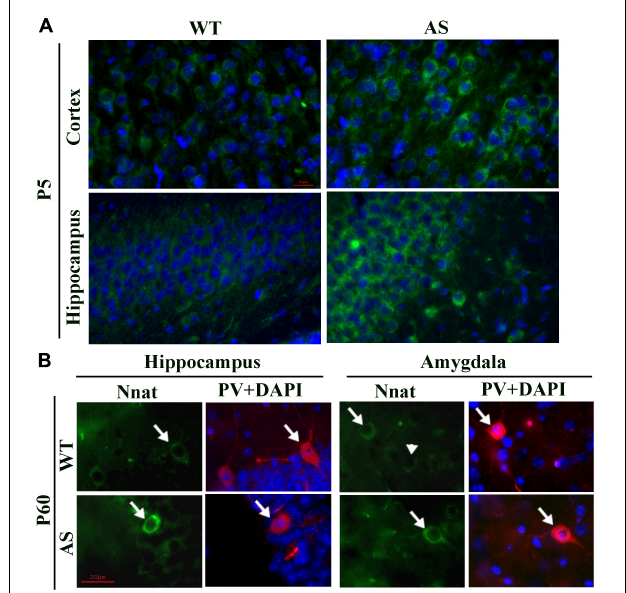
FIGURE 3 | Increased expression of Nnat in AS mice brain. Cortical region of the brain from wild type and AS mice at their different ages (shown in figure) were isolated and subjected to either immunoblot or quantitative RT-PCR analysis of Nnat. (A) Representative immunoblots of Nnat, Ube3a and β -actin. Lane numbers 1 and 2 represents samples from wild type and AS mice respectively. (B) Quantitative analysis of Nnat level shown in (A) . (C) Quantitative RT-PCR analysis of Nnat mRNA. Data represent mean ± SD with three animals in each age group of wild type and AS mice. ∗ P < 0.01 compared to respective control group. E, embryonic; P, postnatal.